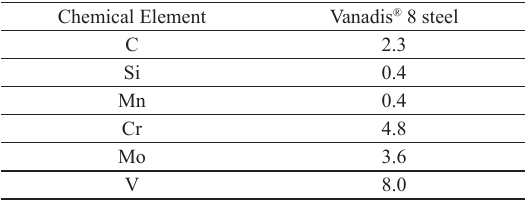
Table 1. Chemical composition of Vanadis ® 8 tool steel (% by